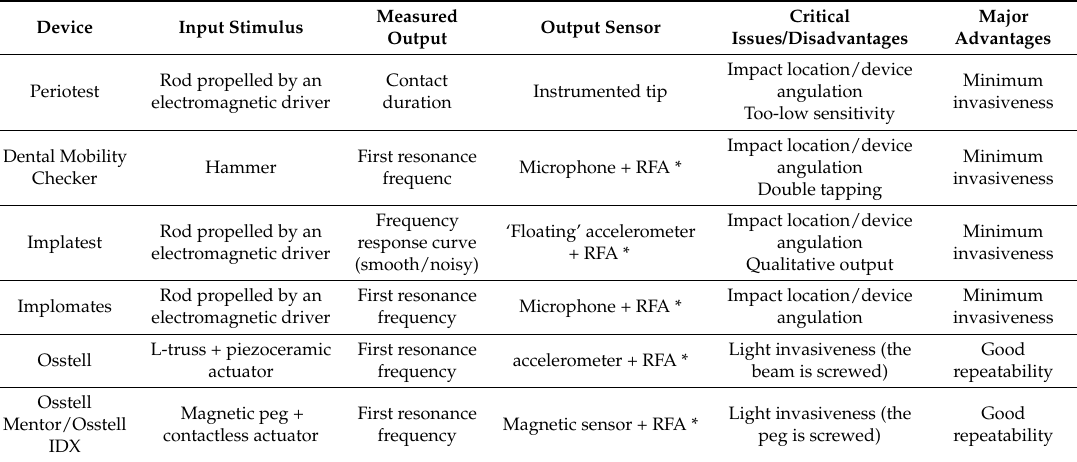
Table 1. Main devices working on bone–implant